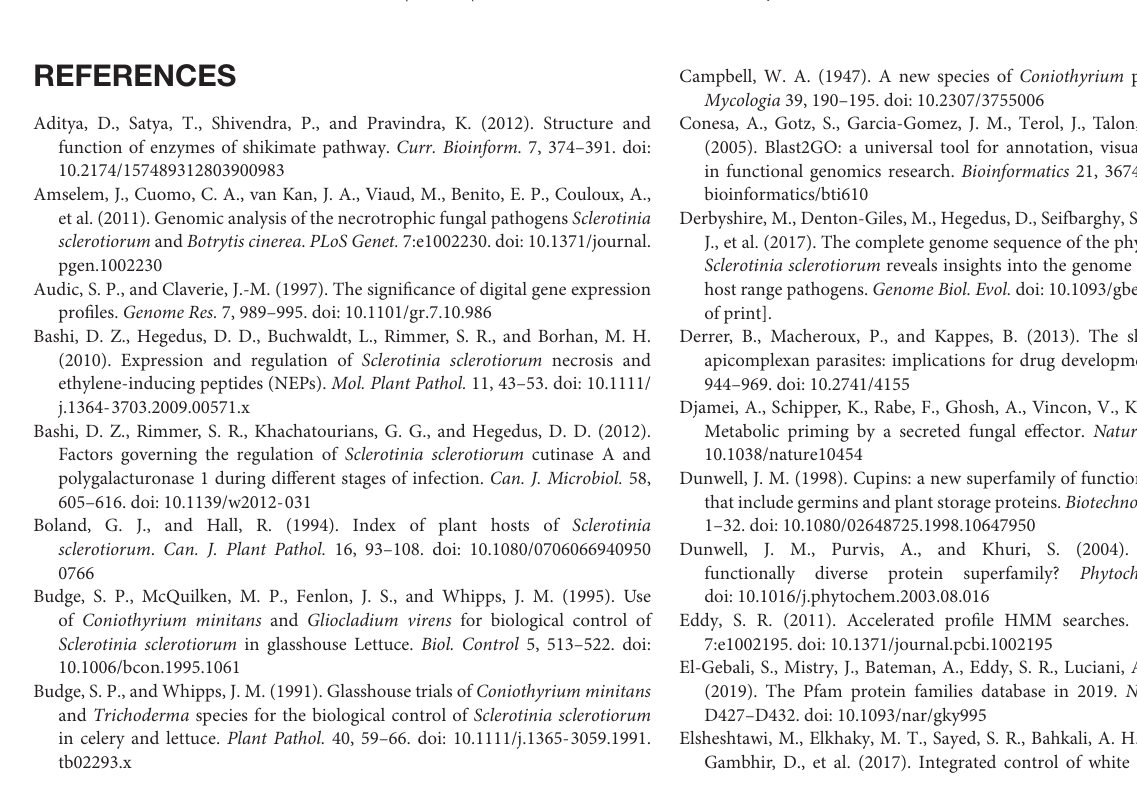
TABLE S1 | The statistics of RNA_seq mapped to the genome of Sclerotinia sclerotiorum . The clean reads with mismatches of no more than two bases